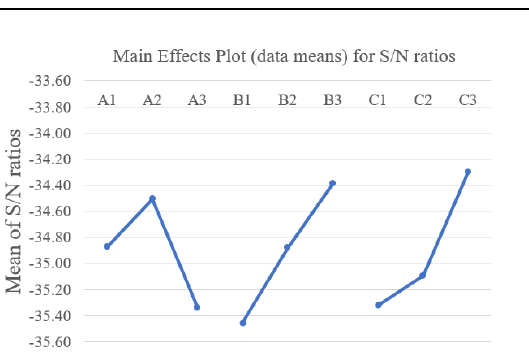
Figure 7. Main effect plot for S/N ratios of the minimum isolation line width.